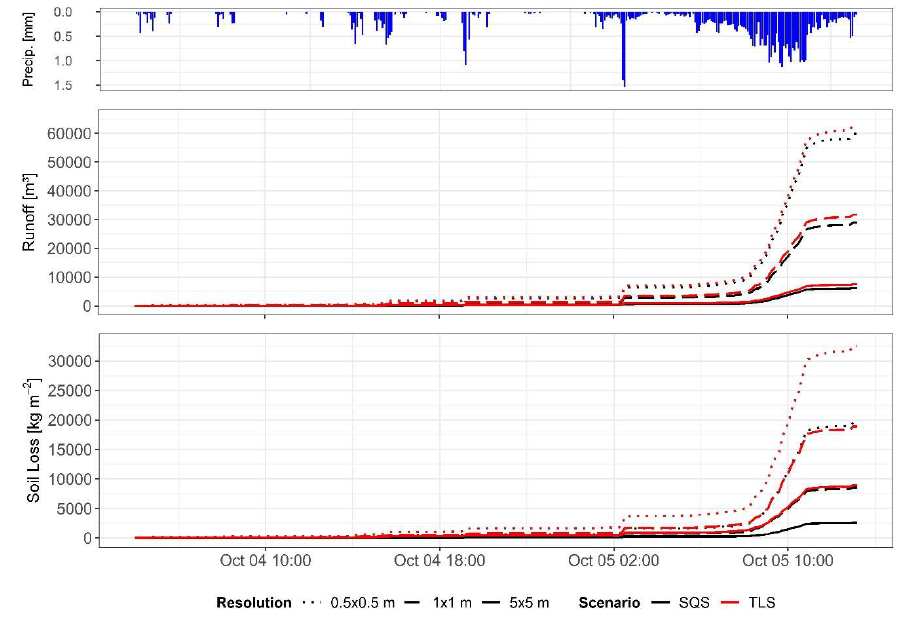
Figure 6. Temporal distribution of runoff and soil loss in E3D for the simulated rainfall event.